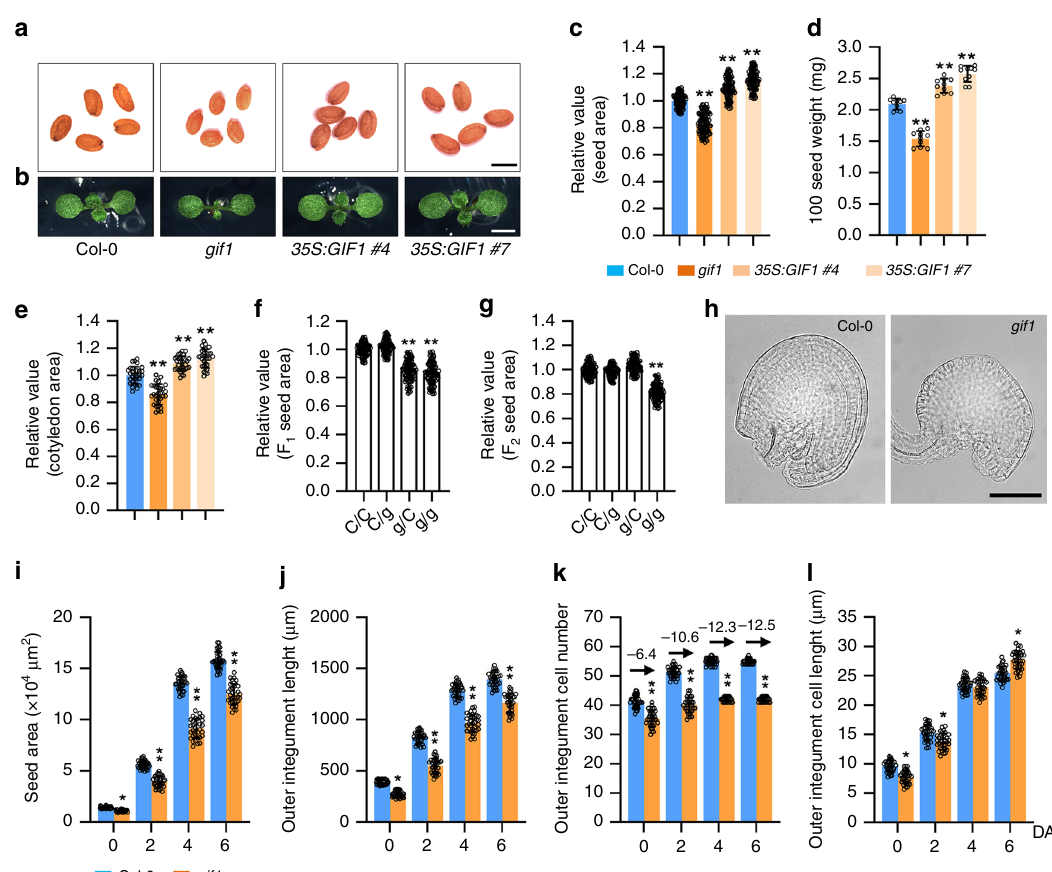
Fig. 5 GIF1 acts maternally to control seed development. a , b The seeds ( a ) and 8-day-old seedlings ( b ) of Col-0, gif1 , 35S : GIF1 # 4, and 35 S : GIF1 # 7. c – e The relative seed area ( c , n = 100), 100 seed weight ( d , n = 10), and cotyledon area ( e , n = 30) of Col-0, gif1 , 35S : GIF1 # 4, and 35S : GIF1 # 7. Seeds from the third to seventh silique on the stem of six plants were used for analysis. Cotyledons from the 8-day-old seedlings were used for analysis. f , g The relative area of F 1 seeds ( f ) and F 2 seeds ( g ) from Col-0/Col-0 (C/C), Col-0/ gif1 (C/g), gif1 /Col-0 (g/C), and gif1 / gif1 (g/g) plants ( n = 100). h The Mature ovule of Col-0 and gif1 plants at 0 DAP (days after pollination). i – l The seed area ( i ), outer integument length ( j ), outer integument cell number ( k ), and outer integument cell length ( l ) of Col-0 and gif1 plants at 0, 2, 4, and 6 DAP (n = 33). Ovules and seeds from six siliques, which were from the fourth silique on the stem of six plants, were used for analysis. Scale bars, 0.5 mm ( a ), 0.2 cm ( b ), and 50 μ m ( h ). Error bars represent ±SE. Different lowercase letters above the columns indicate the signi fi cant difference among different groups, one-way ANOVA P -values: P < 0.05. Asterisk indicates signi fi cant difference from the Col-0, one-way ANOVA P -values: * P < 0.05 and ** P <